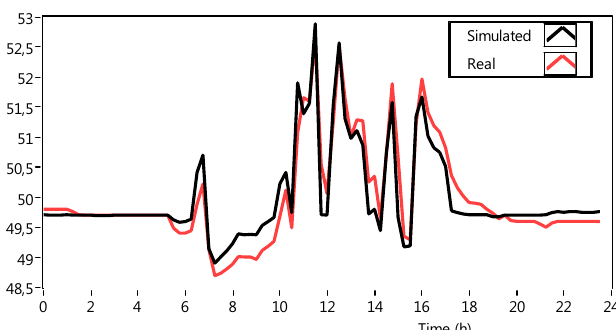
Figure 6. Simulation using identified parameters by particle swarm optimization (PSO) + P algorithm with one day data files.